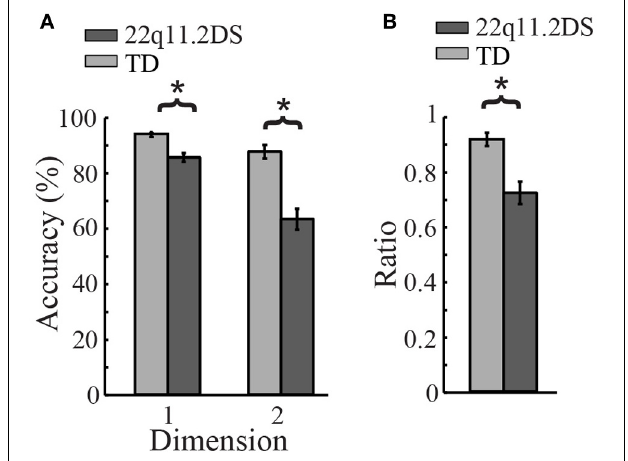
Table 3 for each group’s percent accuracy on both dimensions,